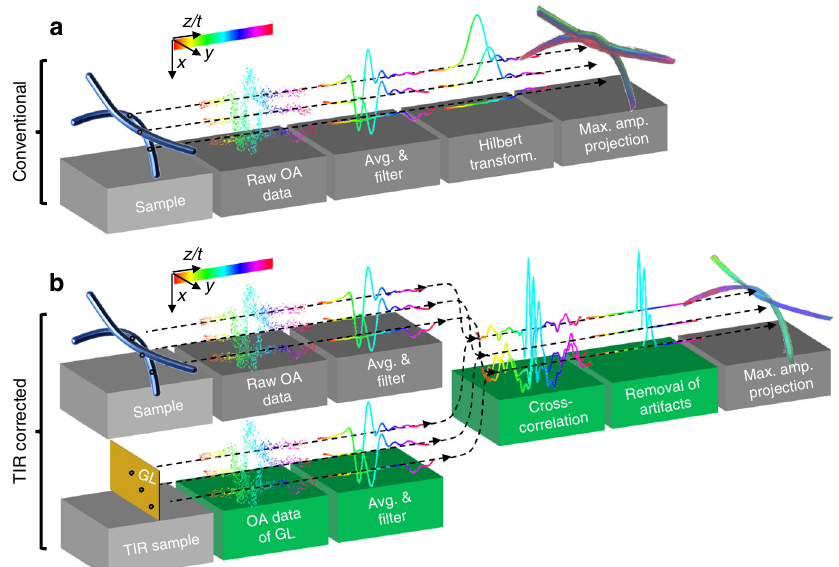
Fig. 6 Sequence for TIR correction of optoacoustic signals using an SMF. Scheme of data processing steps of the a conventional sequence consisting of signal collection, averaging, frequency fi ltering, Hilbert transformation, and projection; and b the herein developed TIR-corrected sequence, in which the recorded, averaged, and fi ltered signals are cross-correlated with the signals of SOAPs of same spatial position followed by artifact removal and